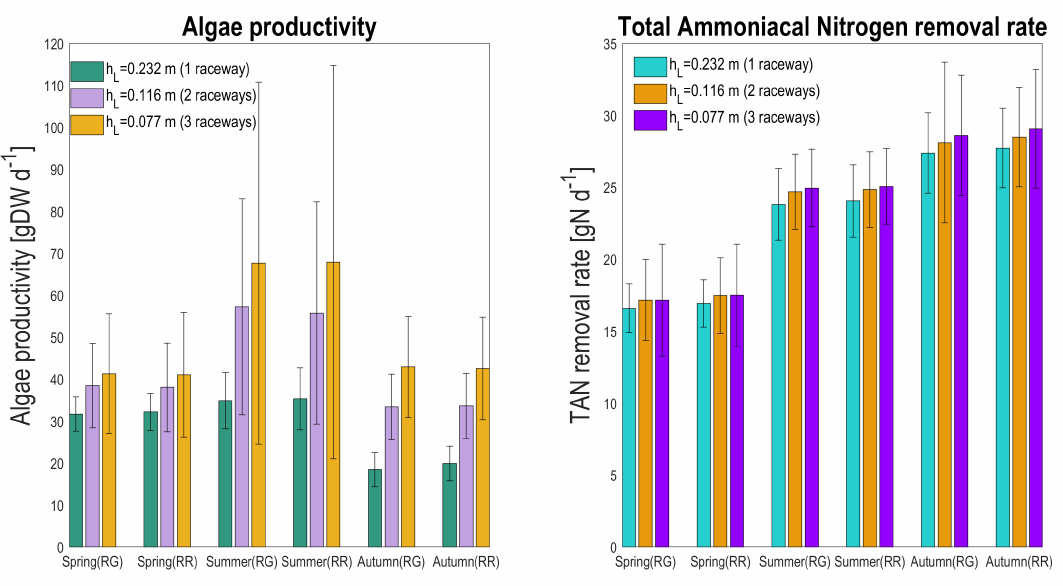
Figure 12. Seasonal average total algal production (gDW d − 1 ) and total TAN removal rate (gN d − 1 ) for the two raceway configurations (RG: raceway on the ground, RR: raceway raised), and depending on the number of raceways to process the same inflow rate (with the same HRT). Scenario with one, two, or three raceways are associated to depths h L of 0.232, 0.116, and 0.077 m,